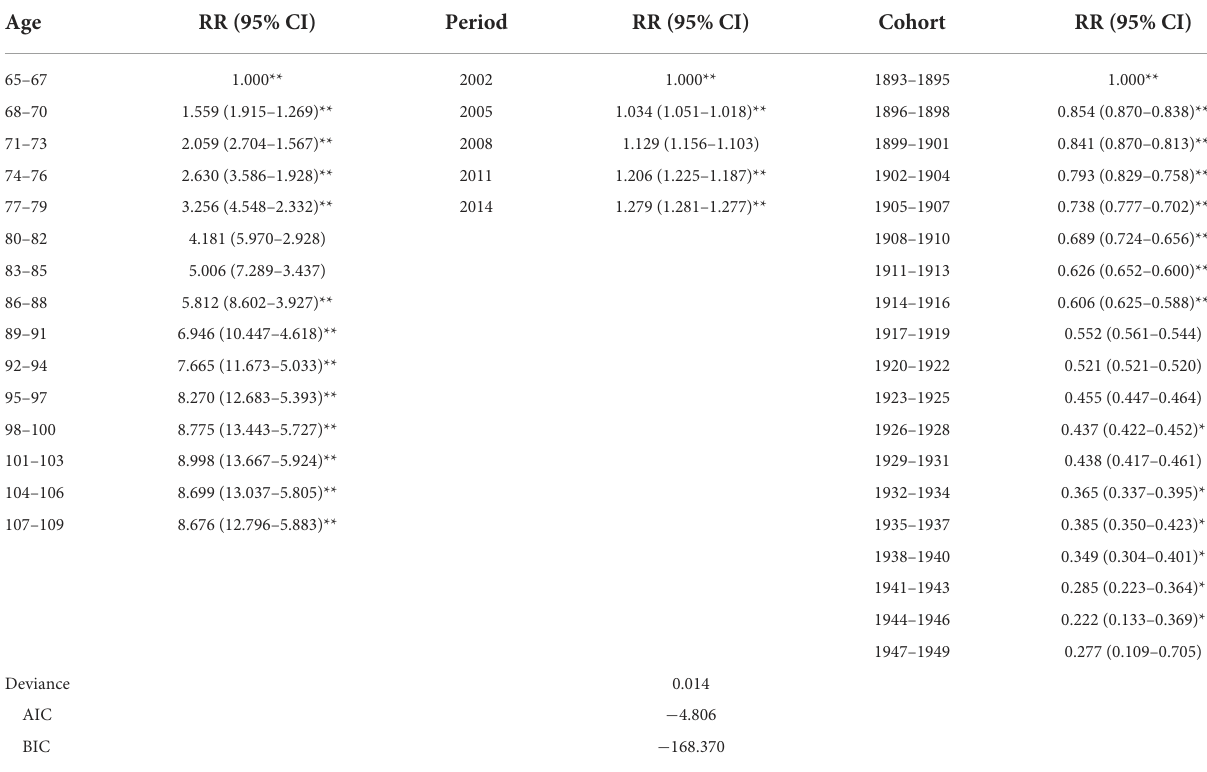
TABLE 2 Results of the APC model of prevalence of frailty among Chinese older adults during